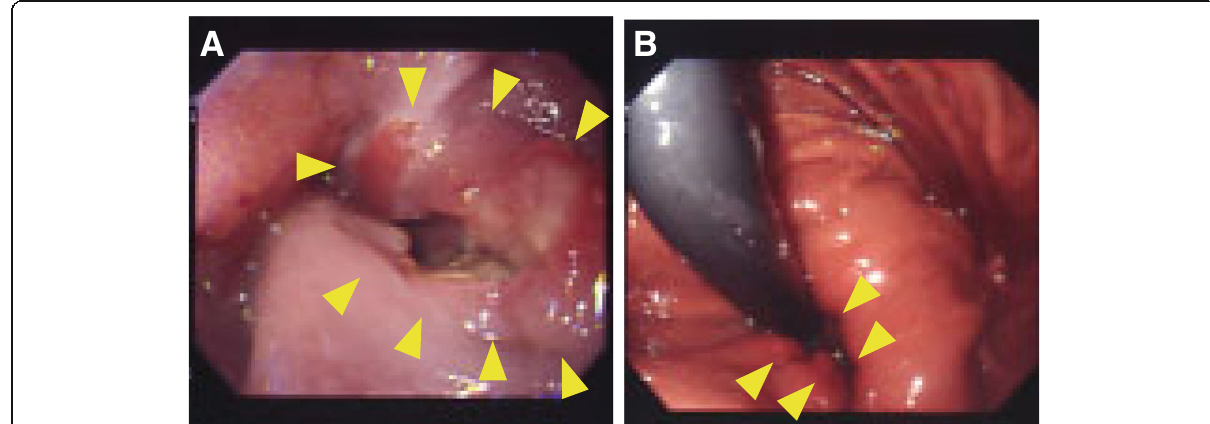
Fig. 1 Endoscopic findings. An ulcerated tumor located in the lower esophagus ( a ) and extending to the upper stomach. The inferior border of the tumor was located in the gastric mucosa in a hiatal hernia ( b )